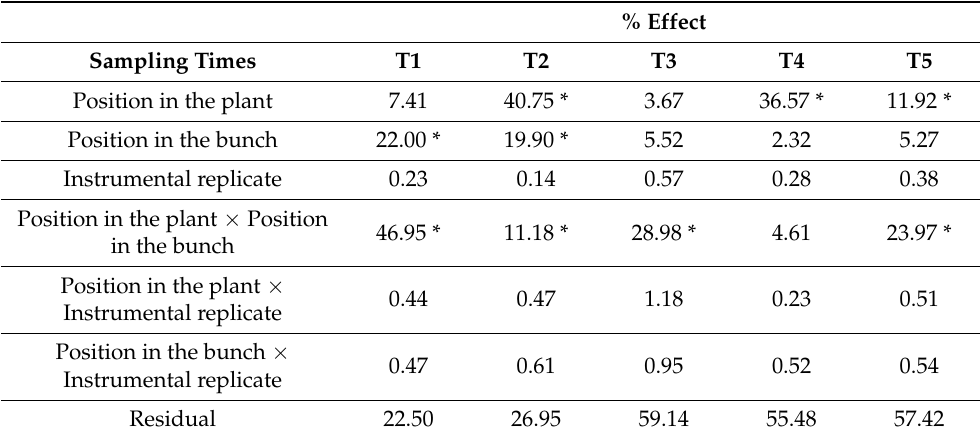
Table 4. Results of the ASCA models for each individual harvest period. T1 to T5: number of the different sampling times. * = Significant effect of the factor ( p <